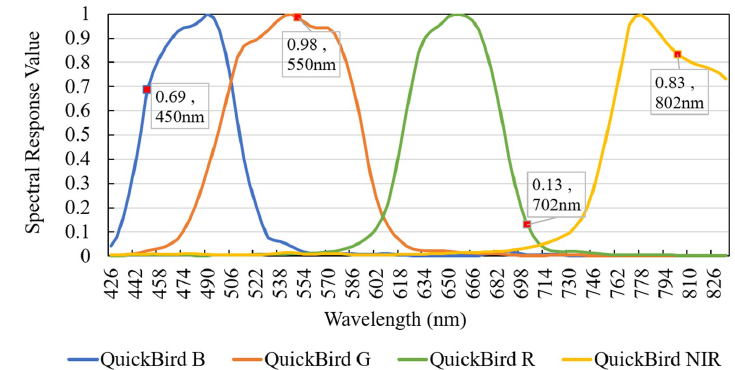
Figure 5. The spectral response function (SRF) of the QuickBird